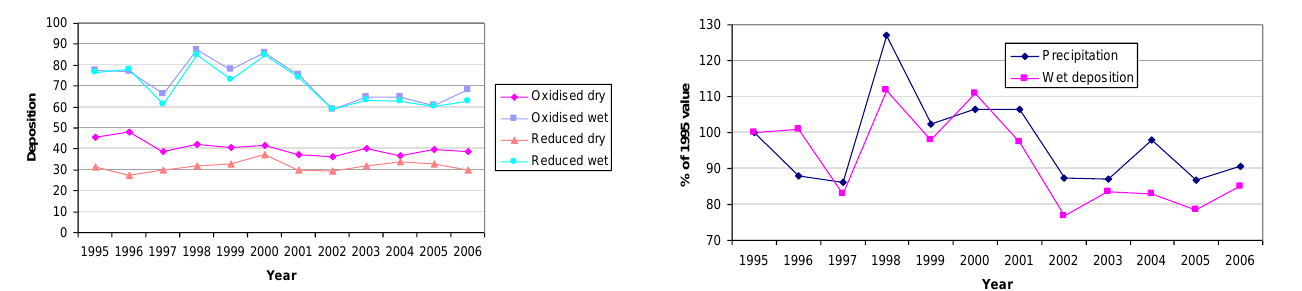
Fig. 6 . Map of annual 2006 oxidised nitrogen deposition (left) and annual 2006 reduced nitrogen deposition (right). Units: mg N m -2 .